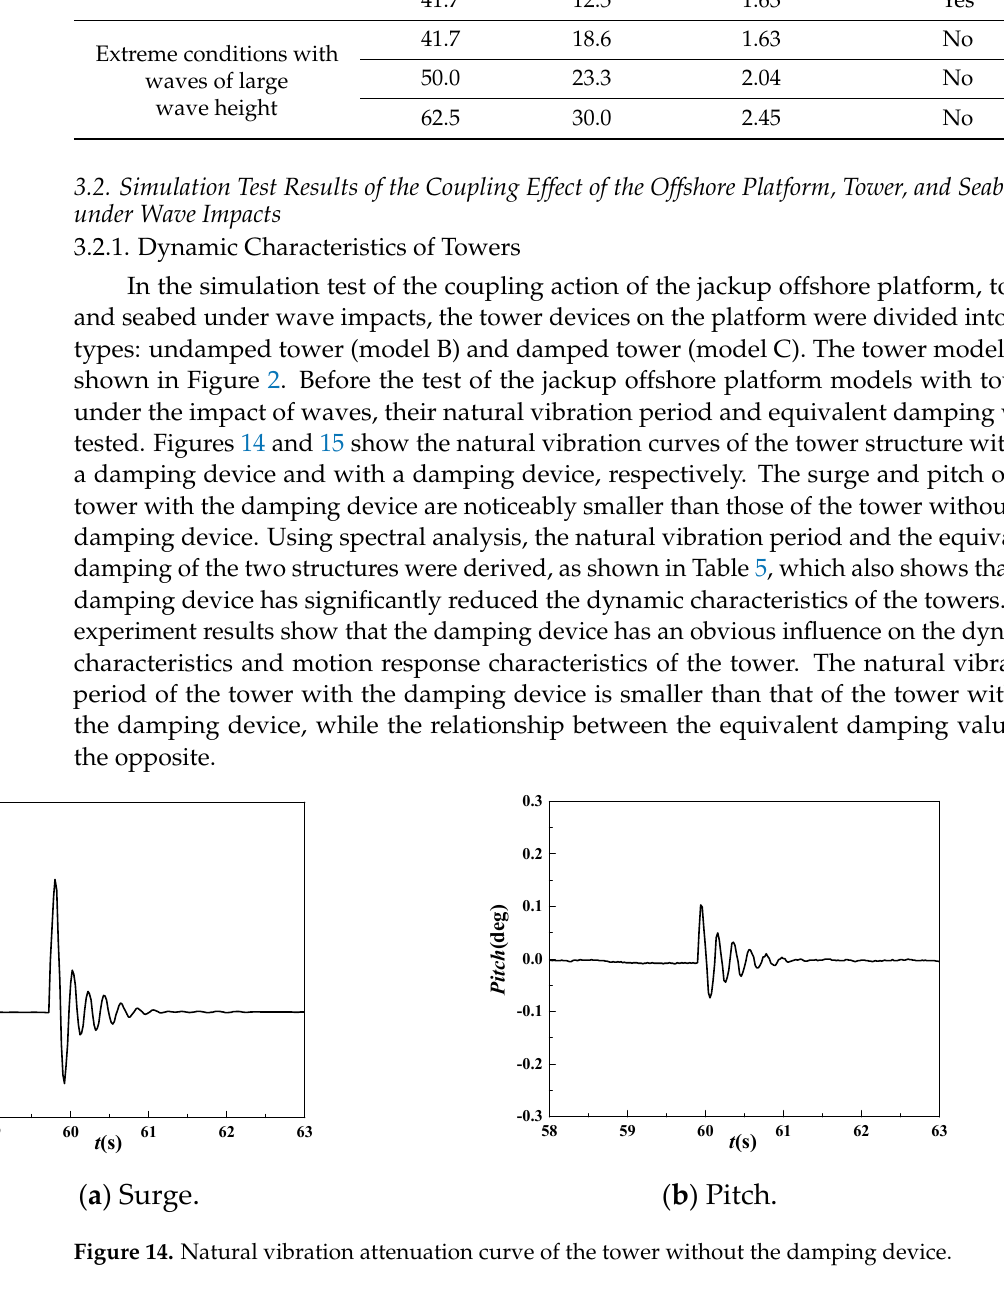
Table 4. S tationary state of the platform model.